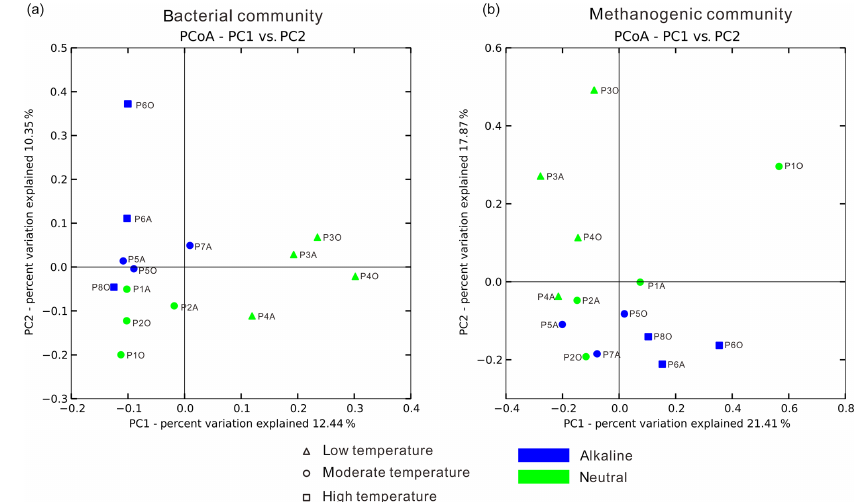
Figure 4. Principal coordinate analysis plot figures based on unweighted UniFrac matrices. Bacterial (a) and methanogenic (b) communities of 14 samples were separately analyzed to delineate the dissimilarity distances between each sample based on phylogenetic classification. The sample dots were categorized in terms of temperature (dot shape) and pH condition (color).